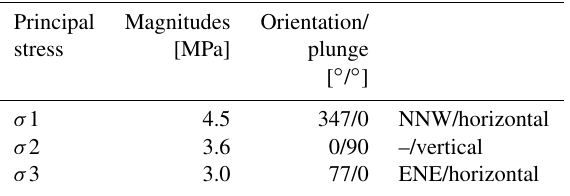
Table 1. Results of stress measurements through overcoring by Mjakischew (1987) at 140m depth in the Reiche Zeche mine. Principal Magnitudes Orientation/ stress [MPa] plunge [ ◦ / ◦ ] σ 1 4.5 347/0 NNW/horizontal σ 2 3.6 0/90 –/vertical σ 3 3.0 77/0